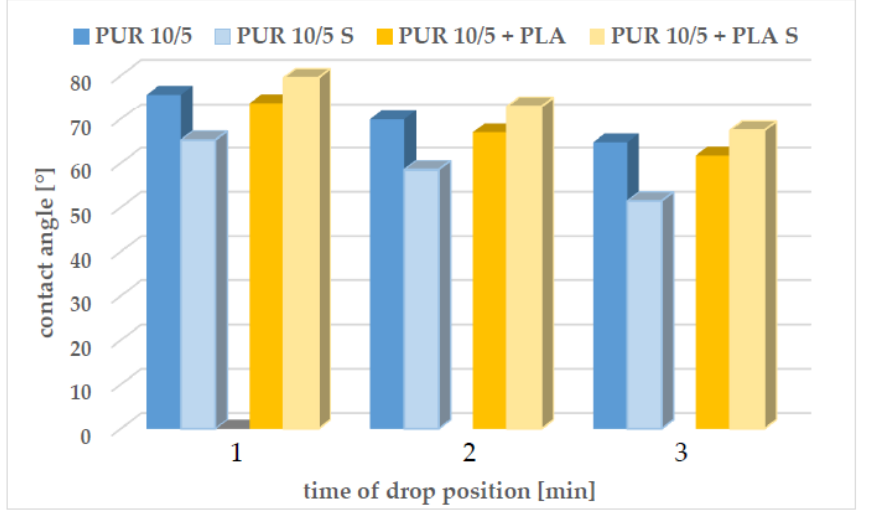
Figure 4. Contact angle (0, 1 and 3 min from the drop position) of the PUR 10/5 and PUR 10/5 + PLA surfaces before and after 36 weeks of exposure to soil.